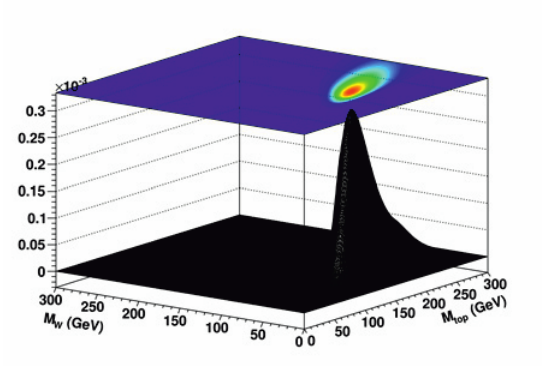
Figure 3. Average PDF weighted Solvability for the 300 test events produced from the same initial top pair event. The distribution is normalized to unit